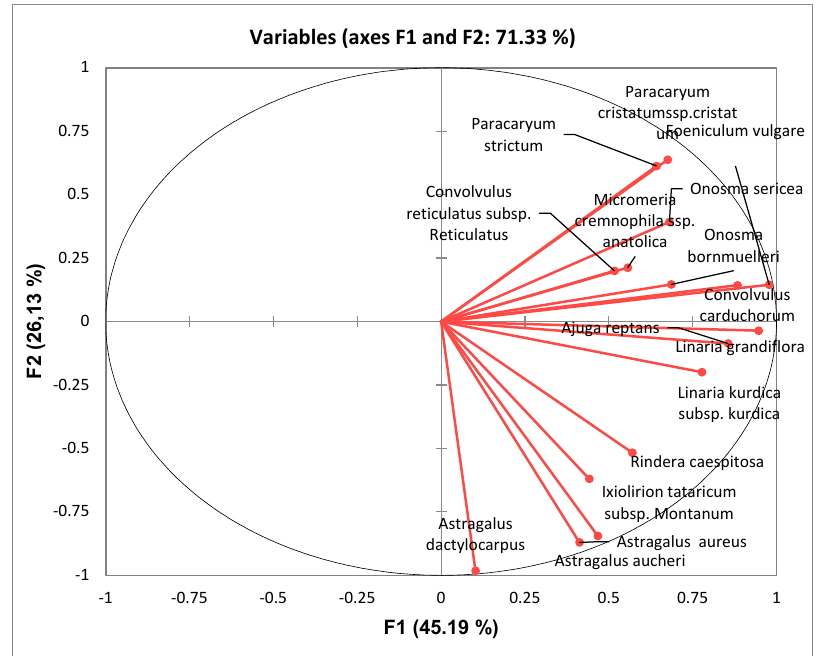
Figure 9. PCA correlation circle from the analysis of the palynological data of taxa.